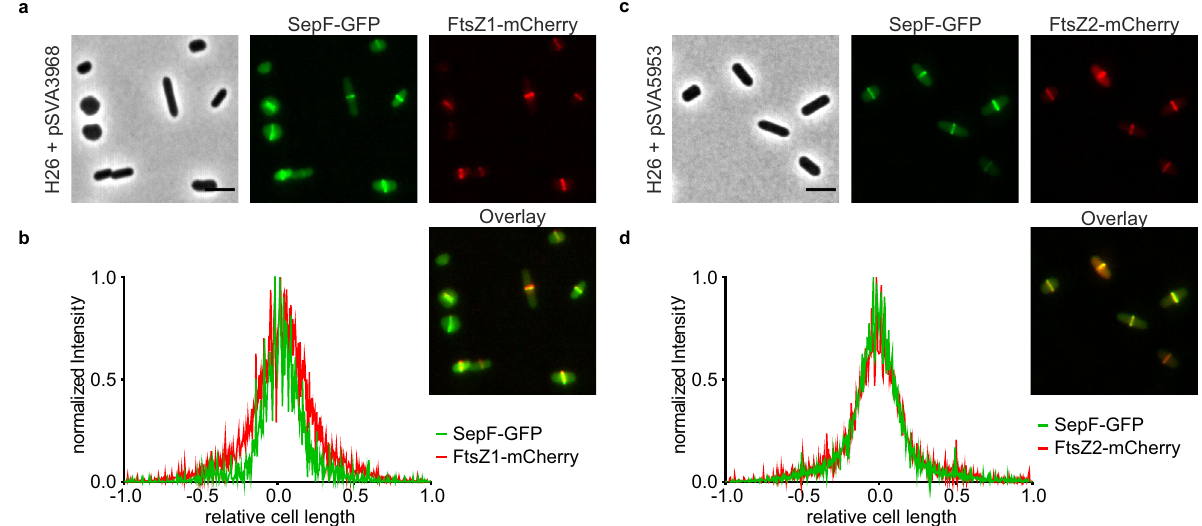
Fig. 3 Co-localization of SepF with either FtsZ1 or FtsZ2. a Fluorescence microscopy of H. volcanii cells expressing SepF-GFP and FtsZ1-mCherry in early exponential phase. b Intensity pro fi le of the normalized fl uorescence signal from the SepF-GFP (green) and the FtsZ1-mCherry (red) construct relative to the cell length. c Fluorescence microscopy of H. volcanii cell expressing SepF-GFP and FtsZ2-mCherry in early exponential phase. d Intensity pro fi le of the normalized fl uorescence signal from the SepF-GFP (green) and the FtsZ2-mCherry (red) construct relative to the cell length. The experiment was repeated at least three times per construct with >1000 cells analyzed. Scale bars: 4 µ